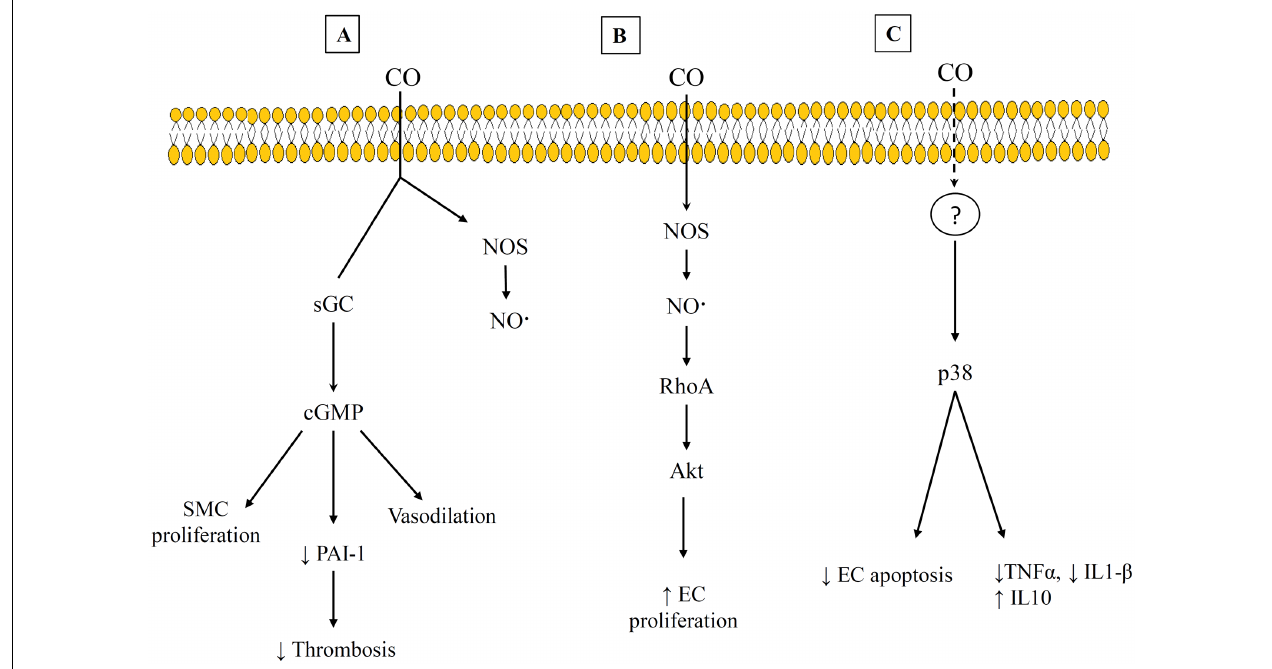
FIGURE 3 | Examples of carbon monoxide (CO) Pathways and heme-binding targets. (A) cGMP-dependent pathway that leads to suppression of SMC and decrease thrombosis. (B) CO interacts with RhoA and Akt to promote EC proliferation. (C) A p38 mitogen activated pathway that exhibits anti-inflammatory effects. References for this figure are listed in the